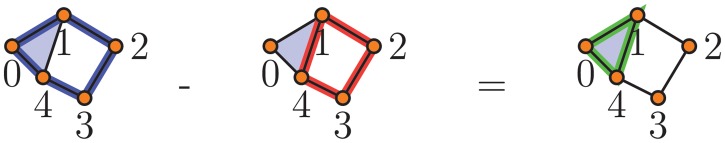
Example of homologous cycles.The blue 1-cycle and the red 1-cycle are homologous (equivalent), because their difference is the boundary of a triangle, shown in green; see text for a detailed explanation.